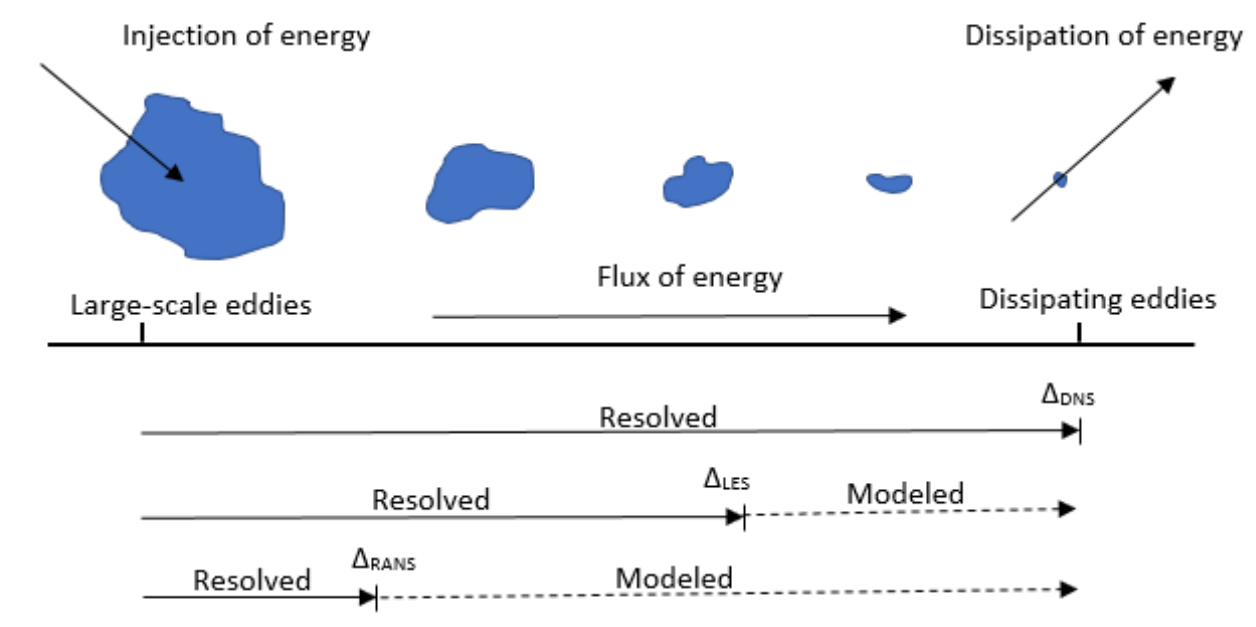
Figure 2. Extent of modelling for certain types of turbulent flows [46].